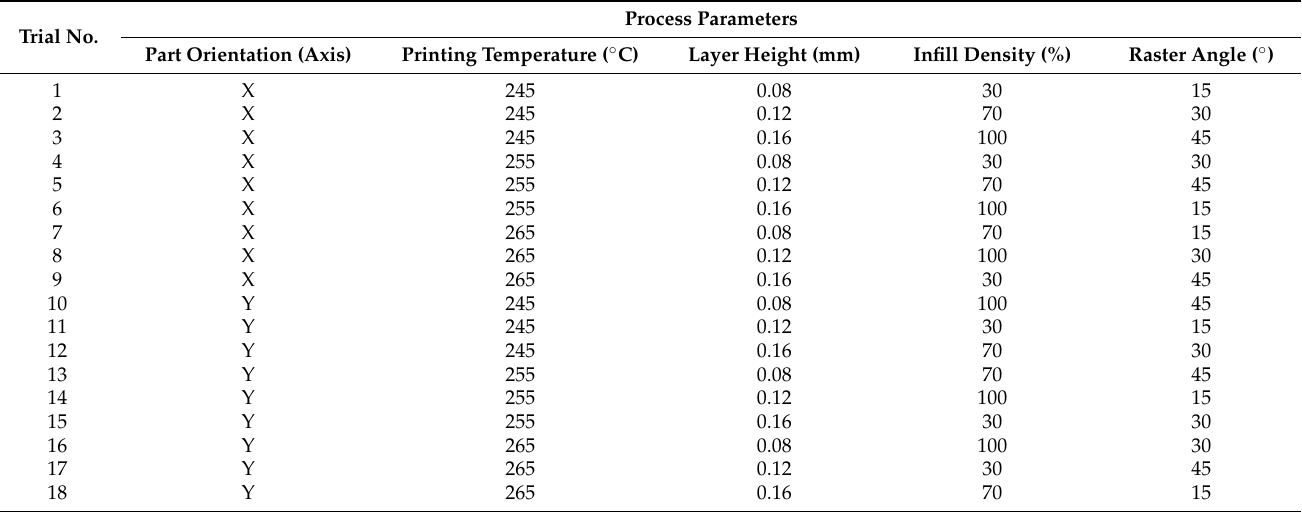
Table 3. L18 orthogonal array experimental